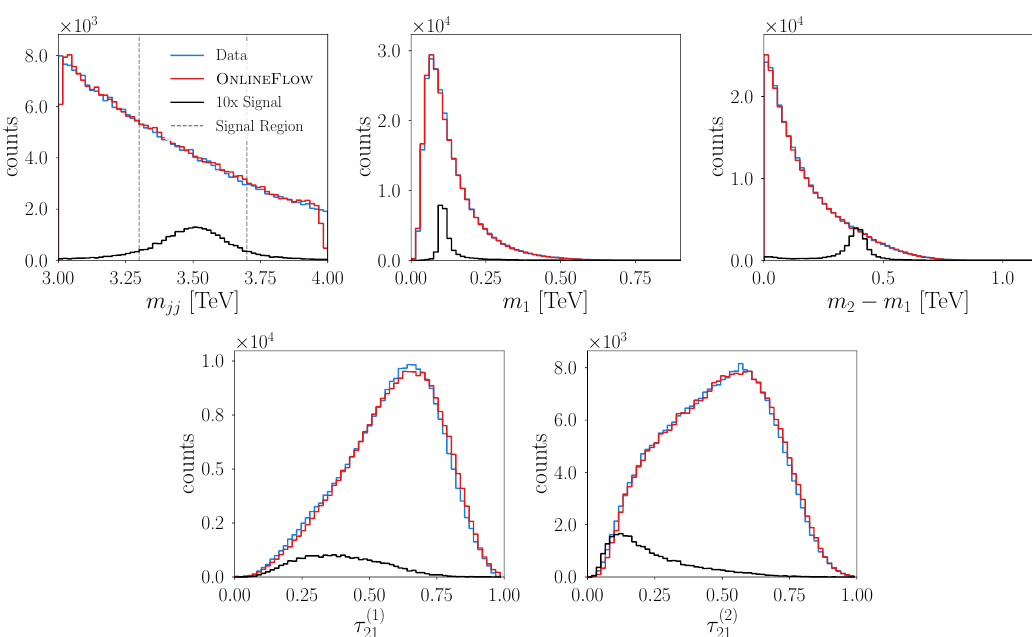
Figure 8: Observables for the LHCO data set, as listed in Eq.(9). We show the original training data, with 1% signal contamination, and the data generated by the flow. The signal region in m is indicated by dotted jj